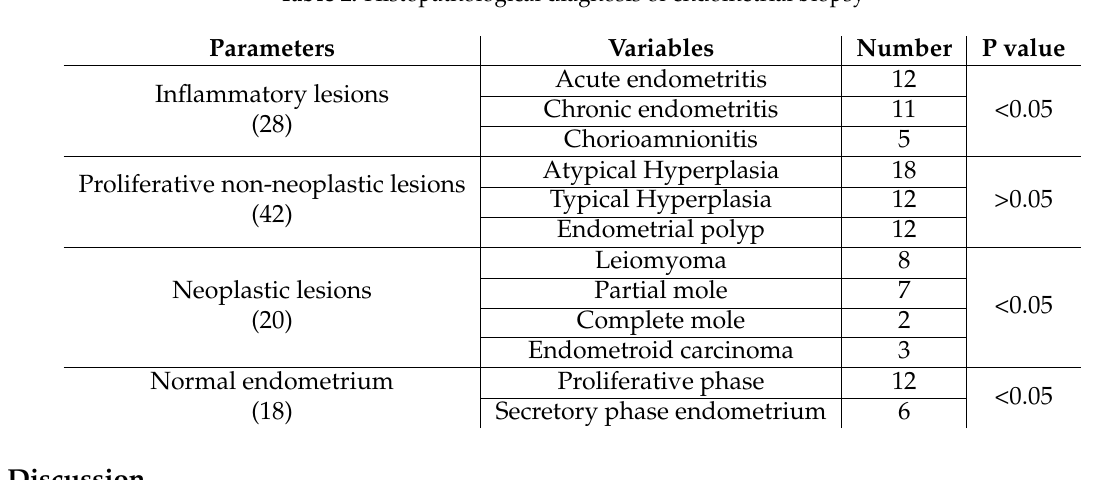
Table 2. Histopathological diagnosis of endometrial